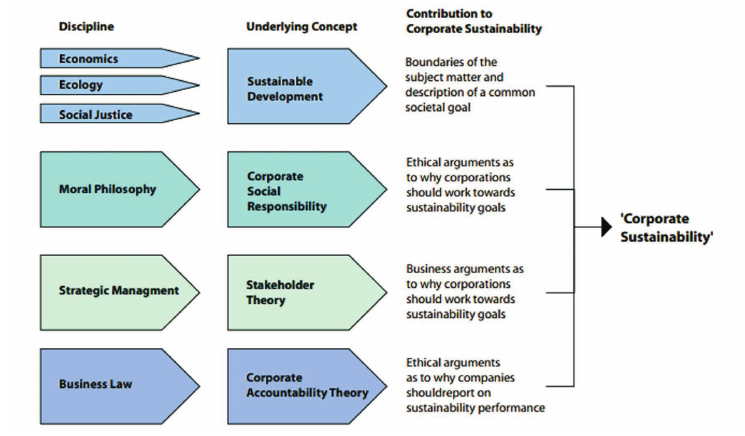
Fig. 1 - Evolution of corporate sustainability. Source: Wilson,